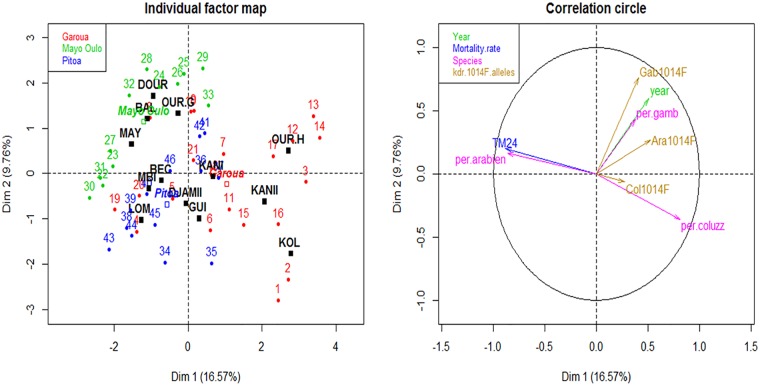
Multiple factor analysis (MFA): Representation of the individuals (localities) and variables on the first plane.Individual factor map showing the interaction between localities and years, coloured according to health districts (left). Correlation circle (right) is for the following sets of quantitative data: mortality rates, Kdr L1014F allele, species composition, and year. Health district was added as a supplementary variable. The analysis on the sets of data over the 5 years study period were done in localities were all the sets of data were available. TM24: TM24: mortality rates 24 hours post exposure to insecticides; per.arbien: percentage of An. arabiensis; per coluzz:percentage of An. coluzzii; per.gamb: percentage of An. gambiae: col1014F: allelic frequency of Kdr L1014F in An. coluzzii; Col L1014F: allelic frequency of Kdr L1014F in An. coluzzii; Ara L1014F: allelic frequency of Kdr L1014F in An. arabiensis; Gab 1014F: allelic frequency of Kdr L1014F in An. gambiae.